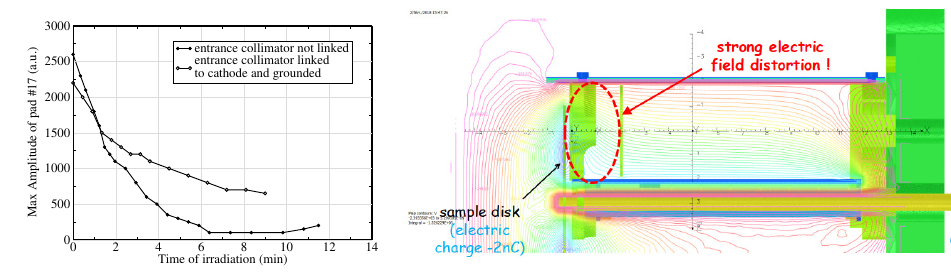
Figure 6. Evolution of the signal amplitude of a pad in the ∆ E region with irradiation time (left). (Right) As fig.5, a static charge of − 2nC is added on the entrance